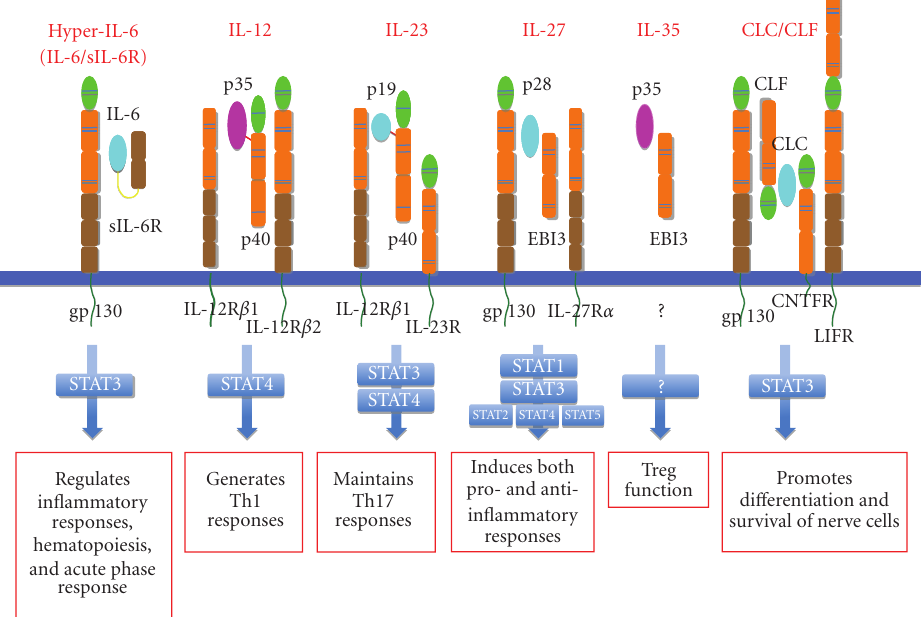
Figure 1: The IL-6/IL-12 heterodimeric cytokine family. IL-27 plays pivotal roles as a pro-inflammatory cytokine to promote the early induction of Th1 di ff erentiation and also as an anti-inflammatory cytokine to limit the T cell hyperactivity and production of pro- inflammatory